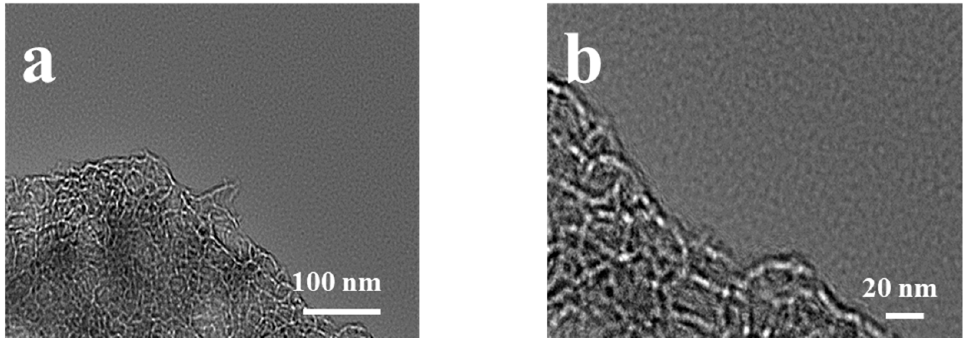
Figure 2. TEM images of TCZn-800 sample at ( a ) 100 nm and ( b ) 20 nm.